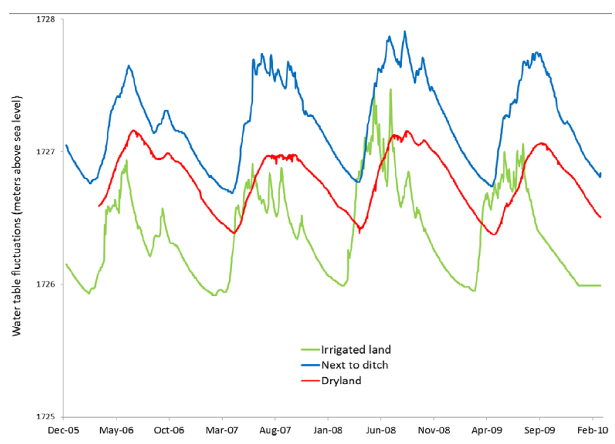
Figure 3. Seasonal water table fluctuations in response to irrigation inputs in one transect of wells in an acequia-irrigated agricultural valley in northern New Mexico.